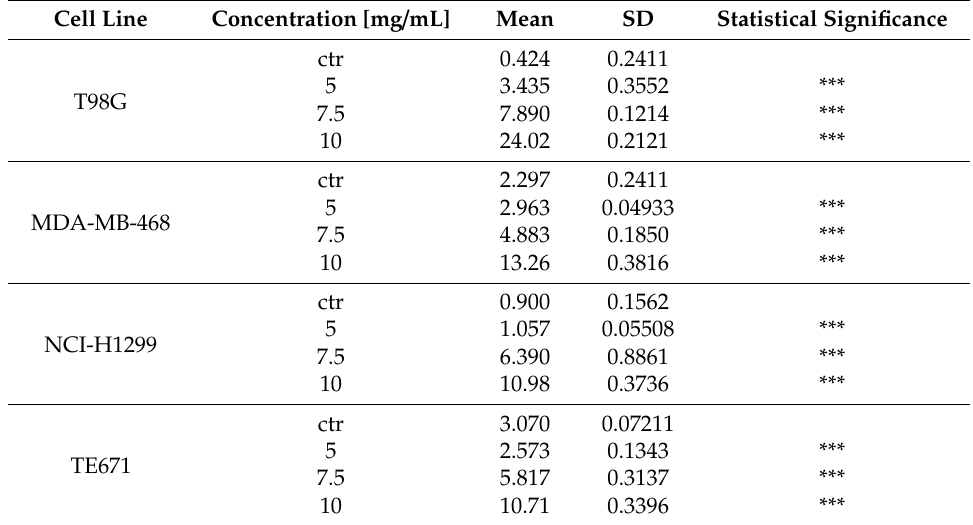
Table 3. The percentage of T98G, MDA-MB-468, NCI-H1299, and TE671 cancer cells positive for active caspase-3 after treatment with MGN for 48 h. Statistical analysis was performed using one-way ANOVA test (*** p < 0.001).